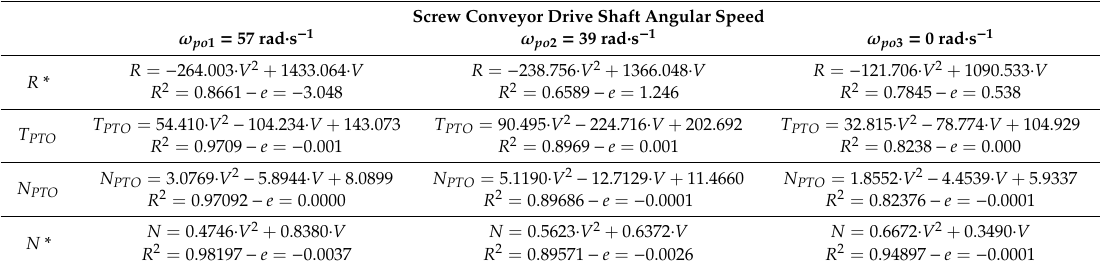
Table 2. Second order regression results of di ff erent V dependent